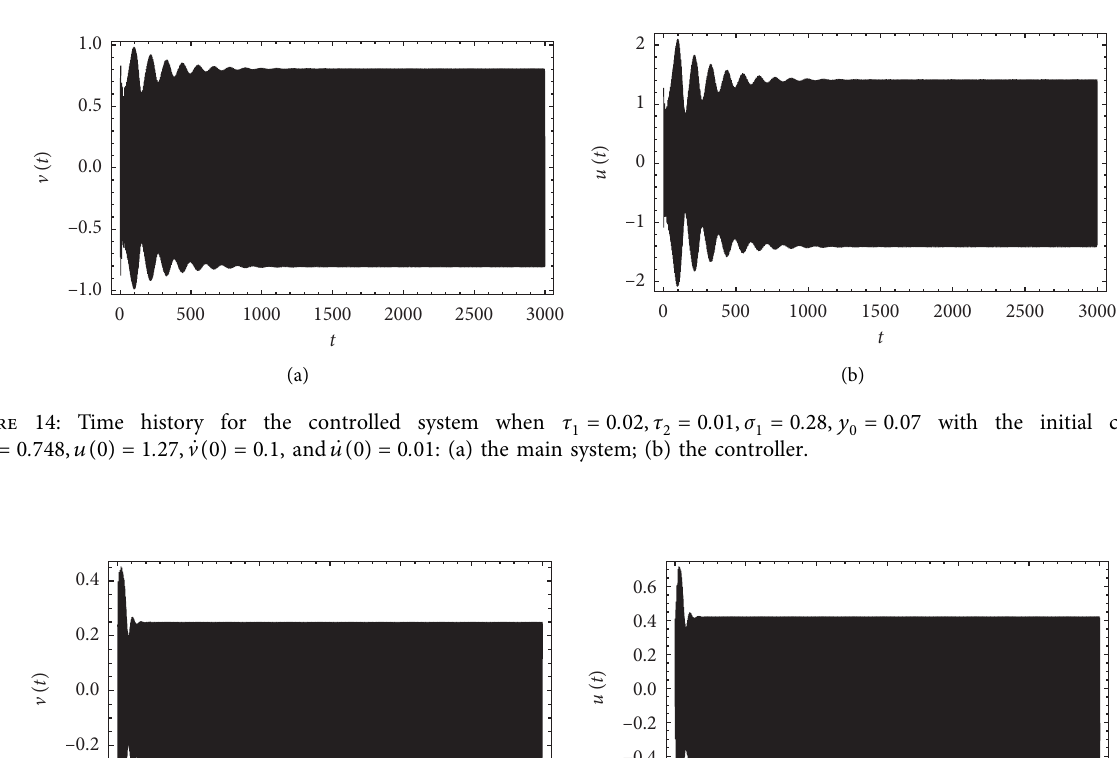
Figure 15: Time history for the controlled system when τ v ( 0 ) � 0 . 239 ,u ( 0 ) � 0 . 408 , _ v ( 0 ) � 0 . 1 , and _ u ( 0 ) � 0 . 01: (a) the main system; (b) the controller. Table 1: Different minimum points of amplitude a � 3 . 06, ζ � 0 . 05, y ω 1